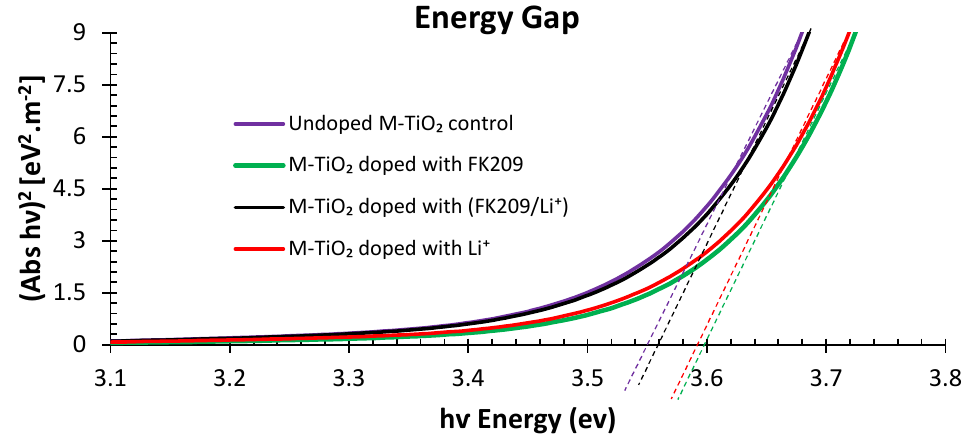
Figure 5. Extrapolation of the energy gap of M-TiO 2 doped with FK209, FK209 /Li + , and Li + , using Tauc plot.